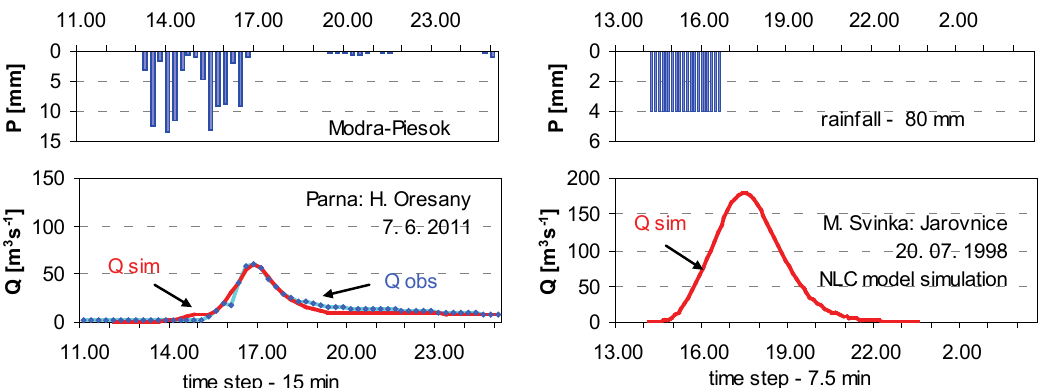
Fig. 2 Measured and simulated flood discharge in Parna and Svinka